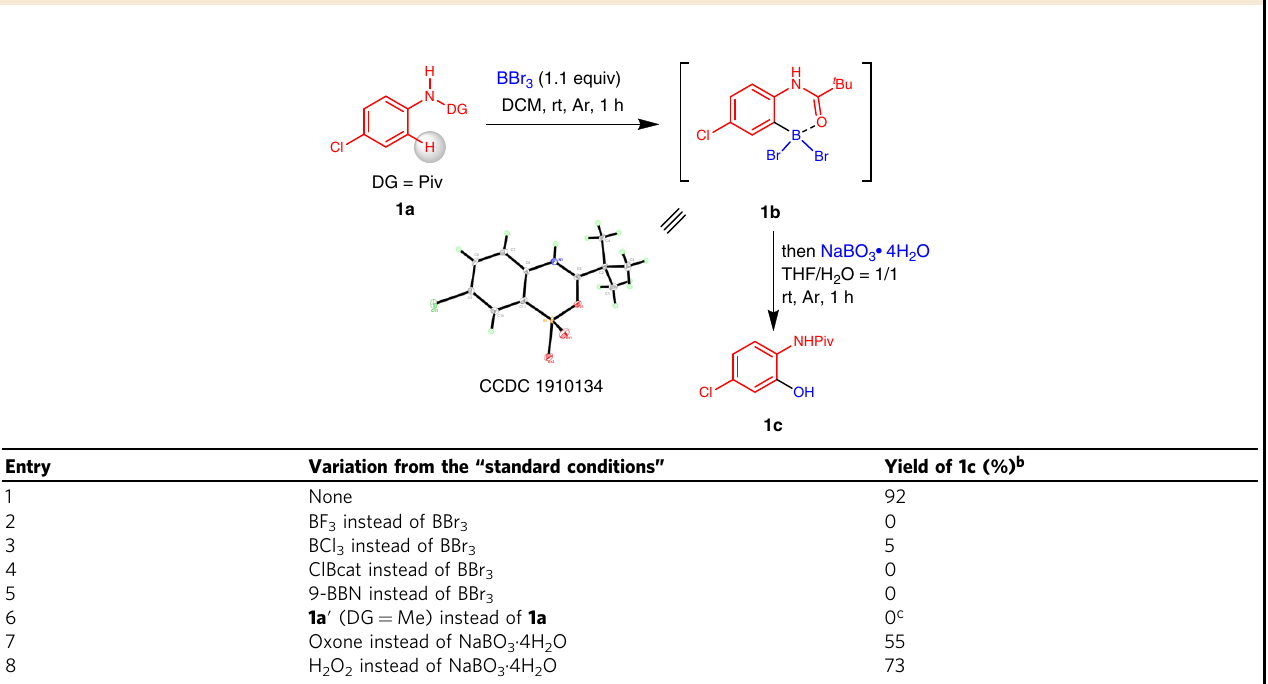
Table 1 Optimization of the reaction conditions.